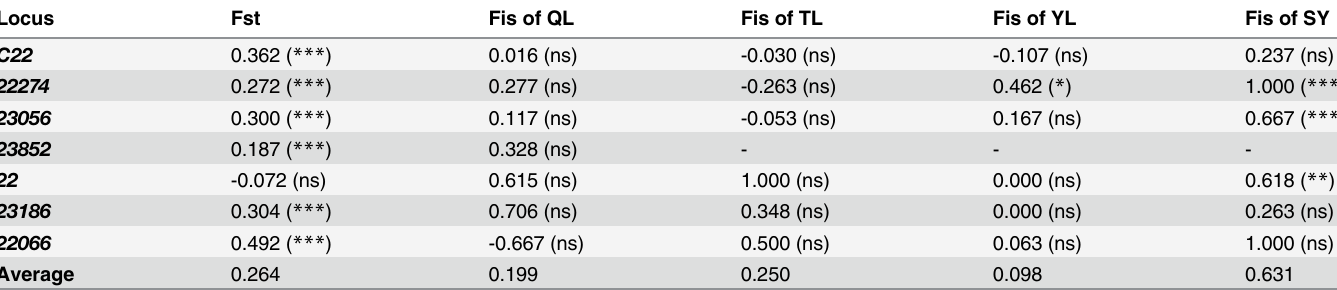
Table 3. Overall Fst of the AMOVA analysis and the Fis inbreeding coefficient for each population at each nuclear locus. Locus